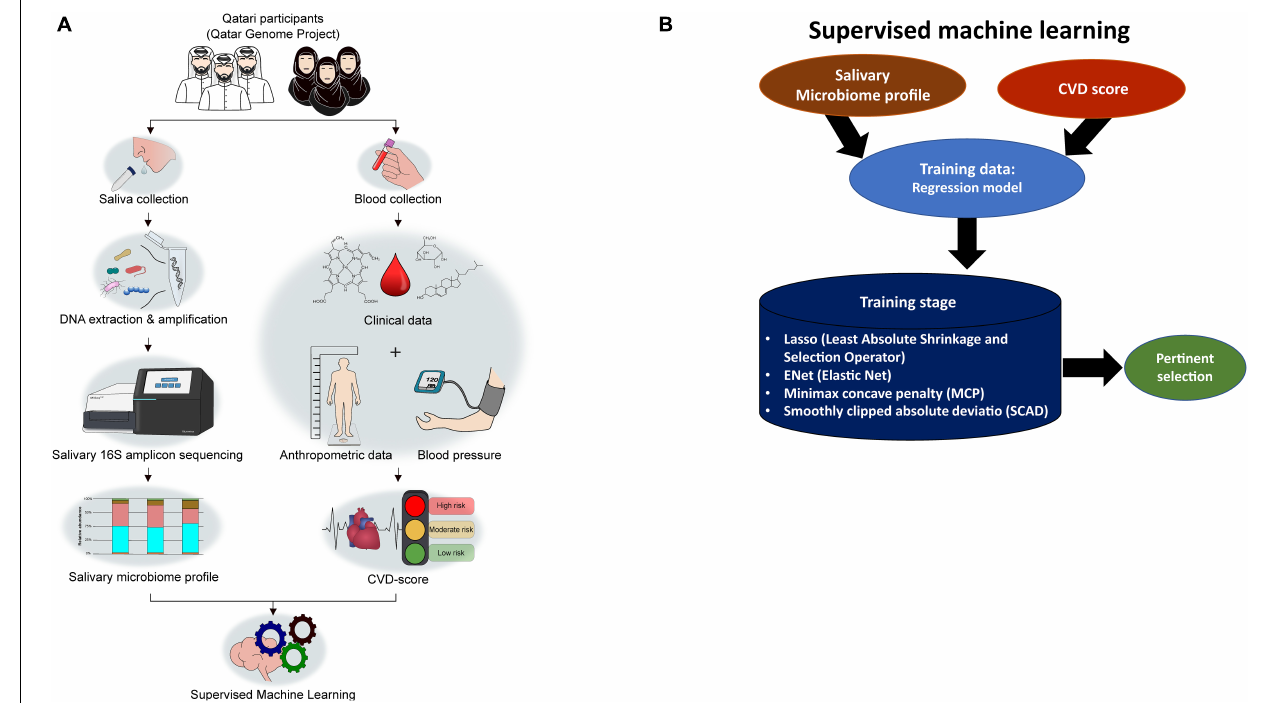
FIGURE 1 | Overall study design from participant recruitment to SM-based CVD marker selection. (A) The study workflow. (B) Strategies applied in Supervised machine learning (ML) to select pertinents.